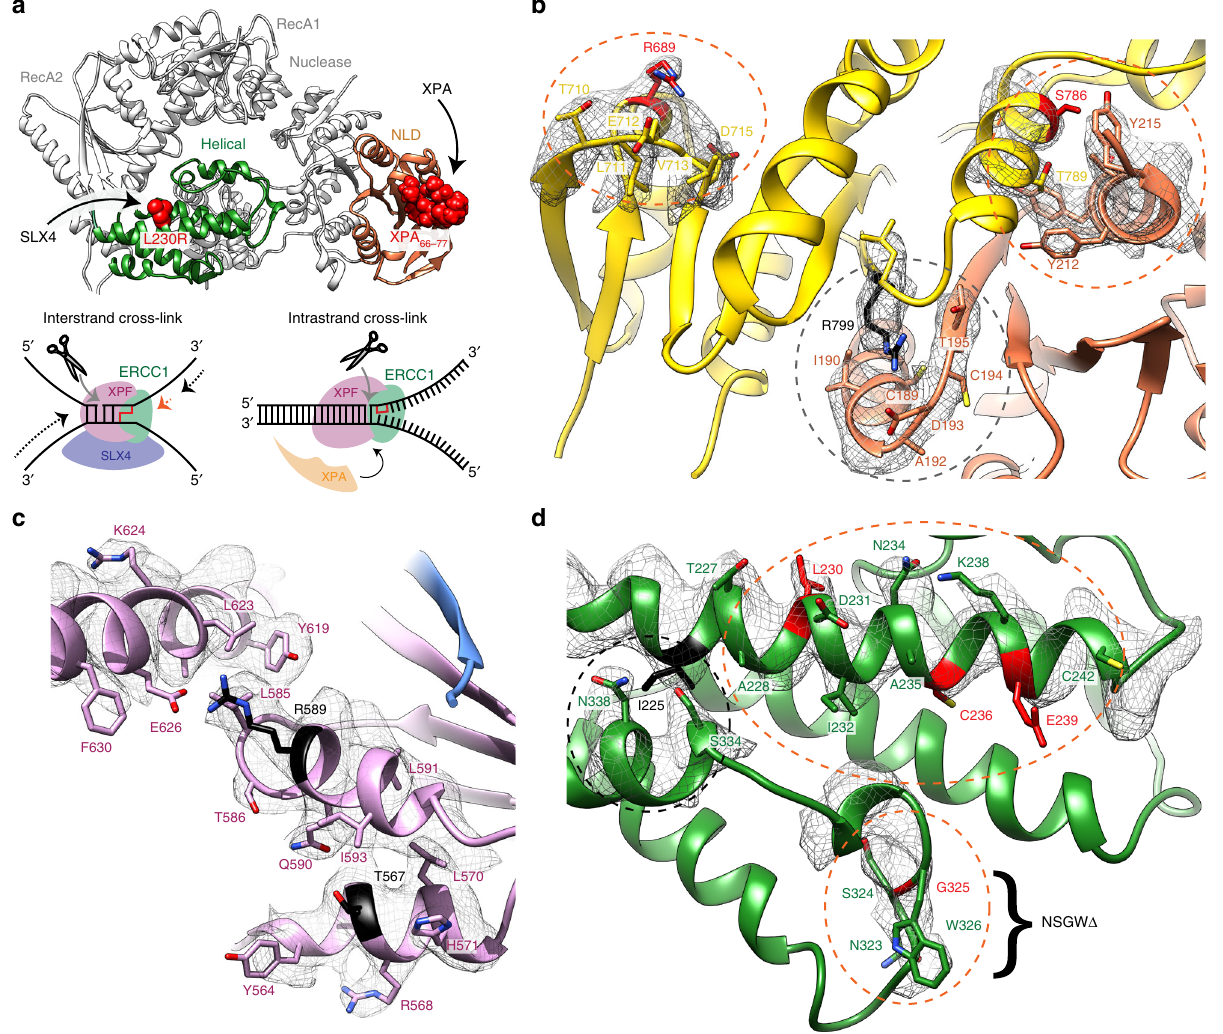
Fig. 3 Mapping XPF – ERCC1 disease mutations and DNA repair pathway recruitment sites. a Top, a ribbon model of XPF – ERCC1 highlighting the spatially distinct binding sites of XPA and SLX4. XPA binds to the ERCC1 NLD (orange) and SLX4 binds to the XPF helical domain (green). The XPA peptide (residues 66 – 77) atoms are displayed as red spheres (PDB: 2JNW). The key SLX4 binding residue L230 sidechain atoms are also displayed as red spheres. Bottom, representative DNA structures targeted by XPF – ERCC1 through SLX4 (interstrand cross-link) or XPA (intrastrand cross- link) recruitment. b – d The molecular environment of patient-derived disease mutations are indicated on the structure, superposed with the cryo-EM map displayed close to the mutation site. Selected residues are displayed using stick rendering coloured by heteroatom. Residues associated with Fanconi anaemia (FA) patient mutations are coloured red whilst those associated with XP are coloured black. Black or orange dashed ellipses indicate the environment close to XP or FA mutations respectively. b Mutations in the XPF nuclease domain and ERCC1 NLD lie close to their interface and give rise to both FA and XP. c XP-associated mutations disrupt key structural contacts in the XPF RecA2 domain are shown overlaid with the composite cryo-EM map. d FA-associated mutations cluster within the XPF helical domain. The helical domain also contains the XP-associated mutant, I225 (black).